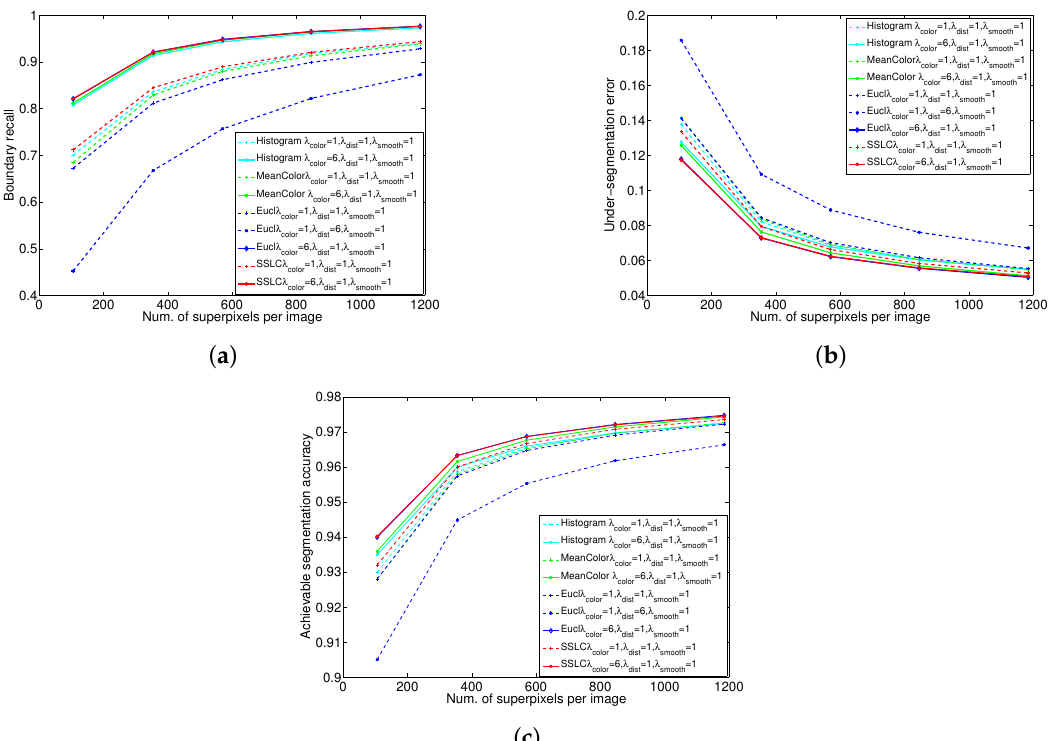
Figure 9. Performance comparisons of the proposed algorithm with different energy terms. ( a ) Boundary recall; ( b ) Under-segmentation error; ( c ) Achievable segmentation